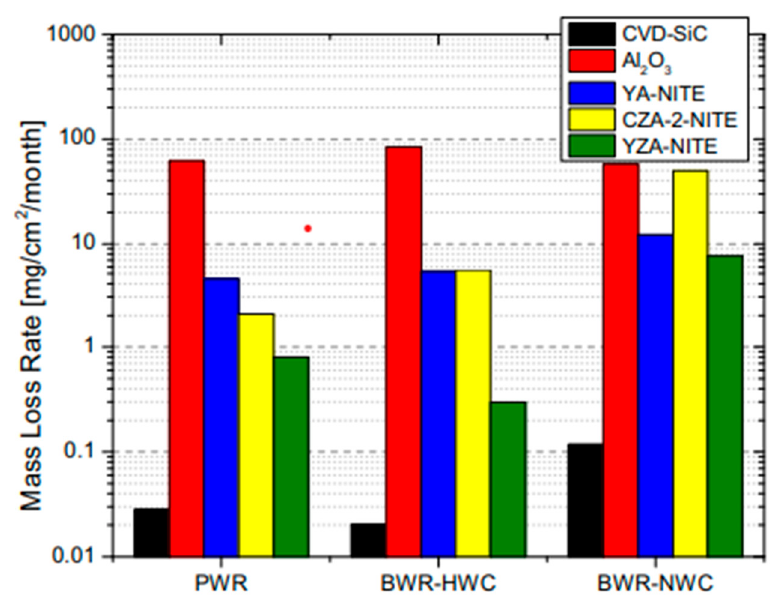
Figure 44. Evolution of mass loss for different SiC materials with different additives. Reprinted with permission from Reference [156]. Copyright 2017 Elsevier.